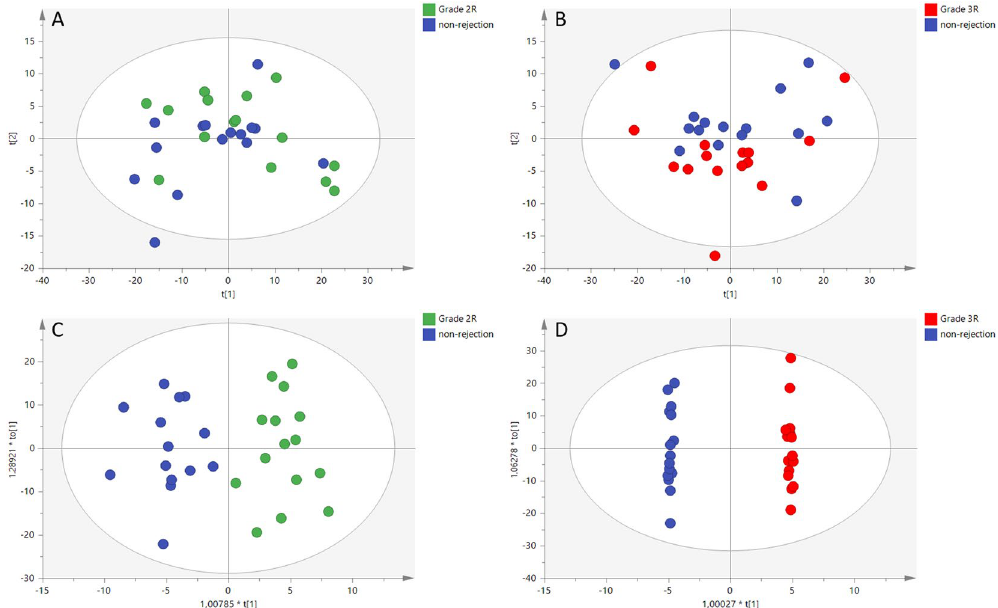
Figure 1. Score plots from PCA and OPLS-DA analysis. PCA score plot ( − ) ESI mode for normal vs. Grade 2 R ( A ); PCA score plot ( − ) ESI mode for normal vs. Grade 3 R ( B ); OPLS-DA score plot ( − ) ESI mode for normal vs. Grade 2 R ( C ); OPLS-DA score plot ( − ) ESI mode for normal vs. Grade 3 R ( D